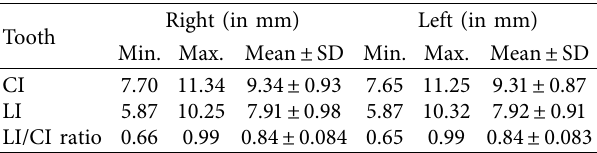
Table 3: Heights (measured along VBM) of clinical crowns of upper incisors.